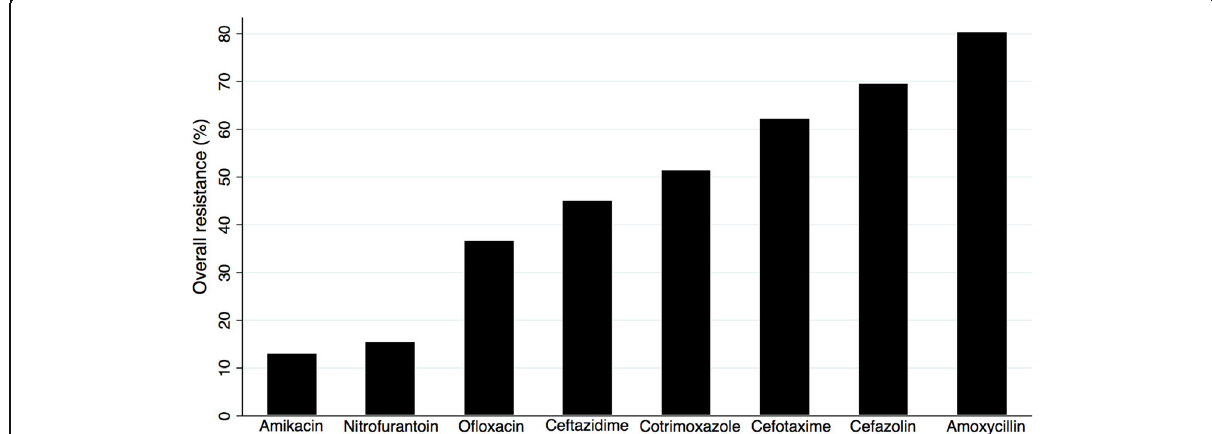
Fig. 2 Antimicrobial resistance patterns of uropathogens in children in Siddhi Memorial Hospital, Bhaktapur, Nepal. The bar graph shows the proportion of uropathogens that showed antimicrobial resistance to commonly used eight antimicrobials in the hospital. The uropathogens were